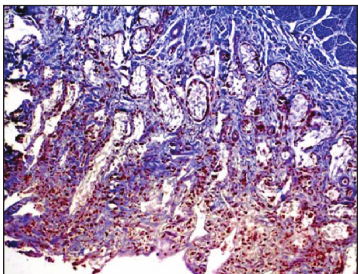
Figure 4: Microphotograph of acellular bovine gallbladder showing compact collagen fibers with moderate porosity than the native tissue (Masson’s trichrome stain,